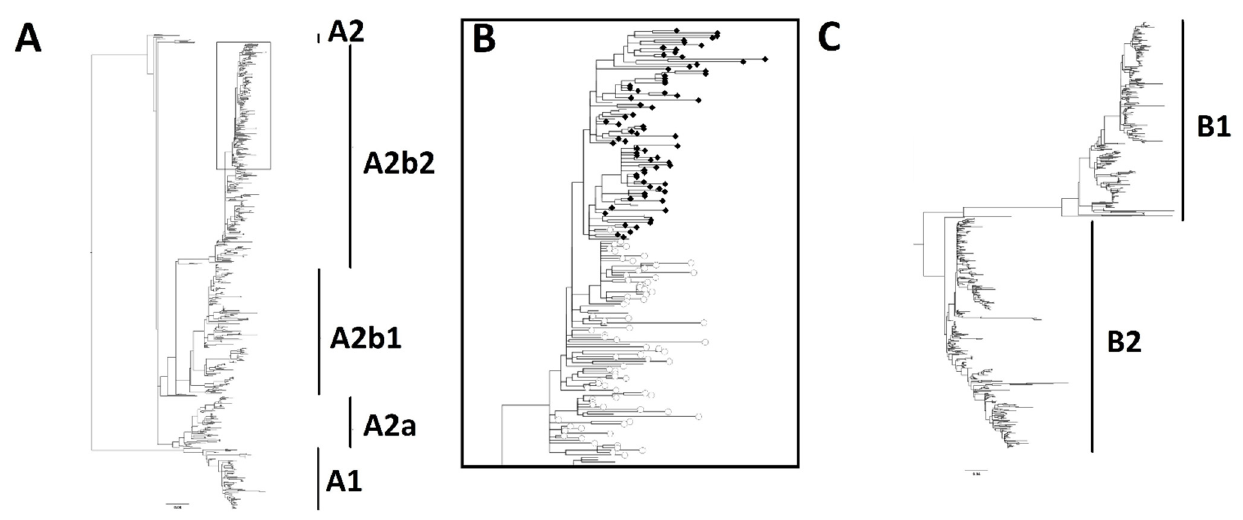
Figure 2. Phylogenetic trees of 765 unique human metapneumovirus (HMPV) A ( A , B ) and 751 unique HMPV B ( C ) complete G gene ectodomain sequences generated by a Maximum Likelihood analysis with the use of 44 and 49 reference sequences, respectively. The box in panel ( A ) is enlarged in panel ( B ), where A2b2 sequences with 111-nt (closed diamonds) and 180 nt (open circles) partial duplications can be identified.